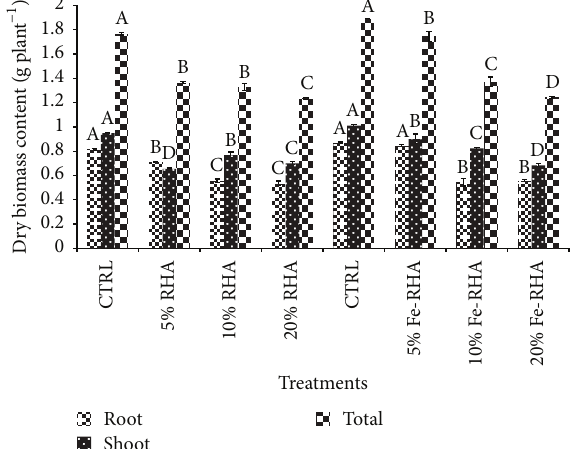
Figure 5: Shoot, root, and total dry biomass of vetiver grass grown in gold mine amended with Fe-RHA and RHA (mean 𝑛 = 3 , ± SD). Different letters correspond to significant differences between rates of the same ash ( 𝑃 < 0.05